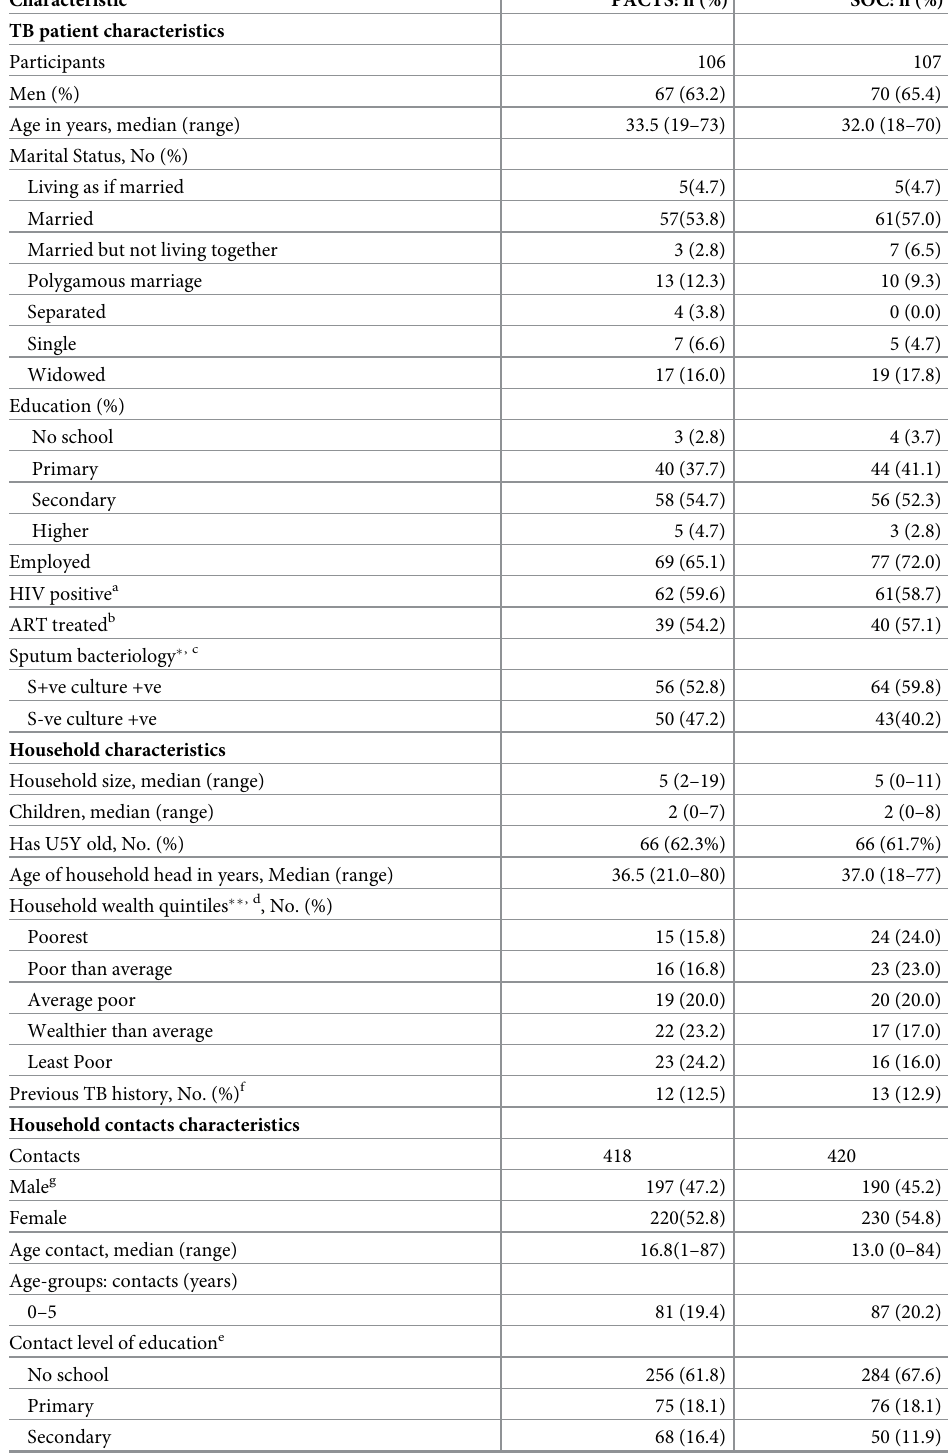
Table 1. Baseline characteristics of participants, household members and household